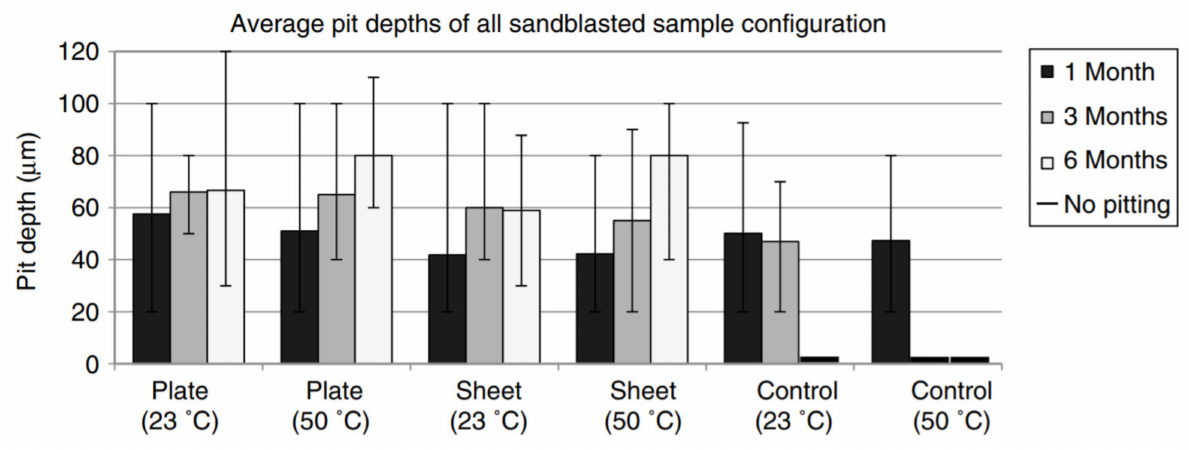
Figure 3. Pit depths of all sandblasted specimens for up to 6 months of submergence [58]; used with permission from Advances in Structural Engineering, SAGE,